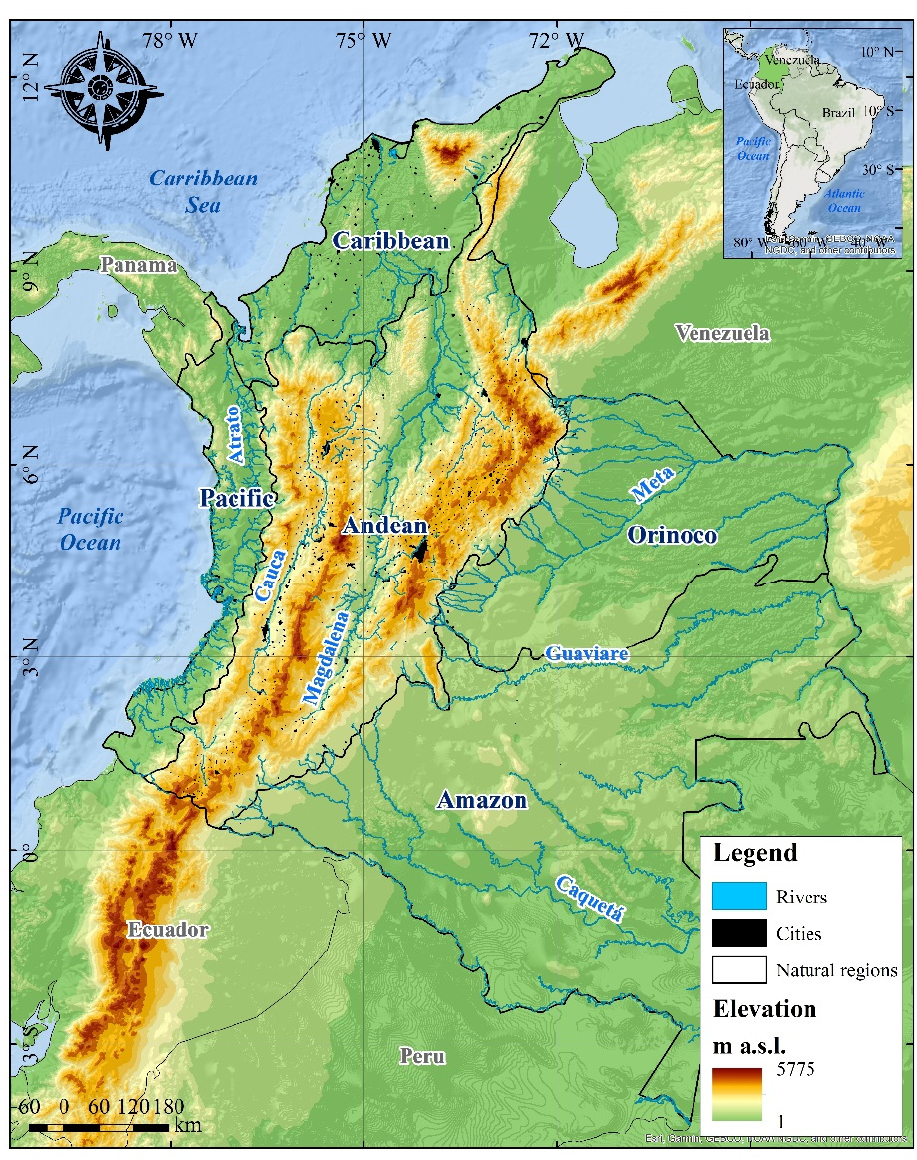
Figure 1. Location of the study area and Colombian natural regions.